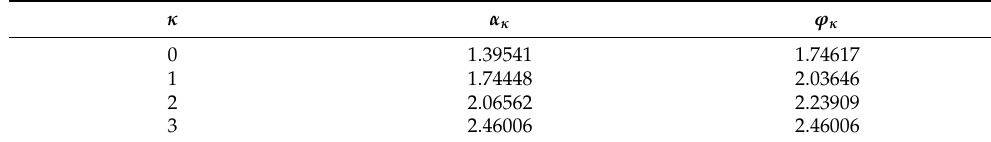
Table 5. Values of α κ and ϕ κ (in radians) for Example